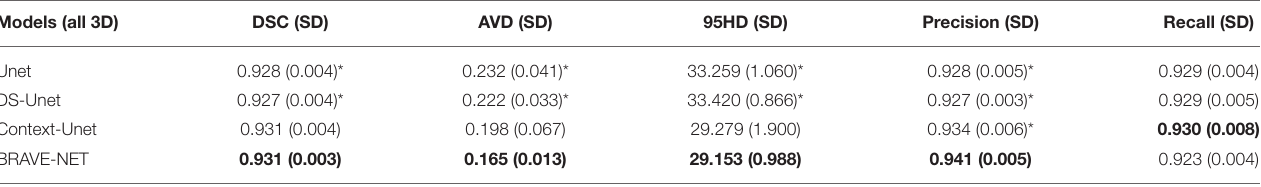
TABLE 3 | Test results of cross-validation for all models, average (SD) over all folds are given. Best overall performance was achieved by our proposed BRAVE-NET model. Models (all